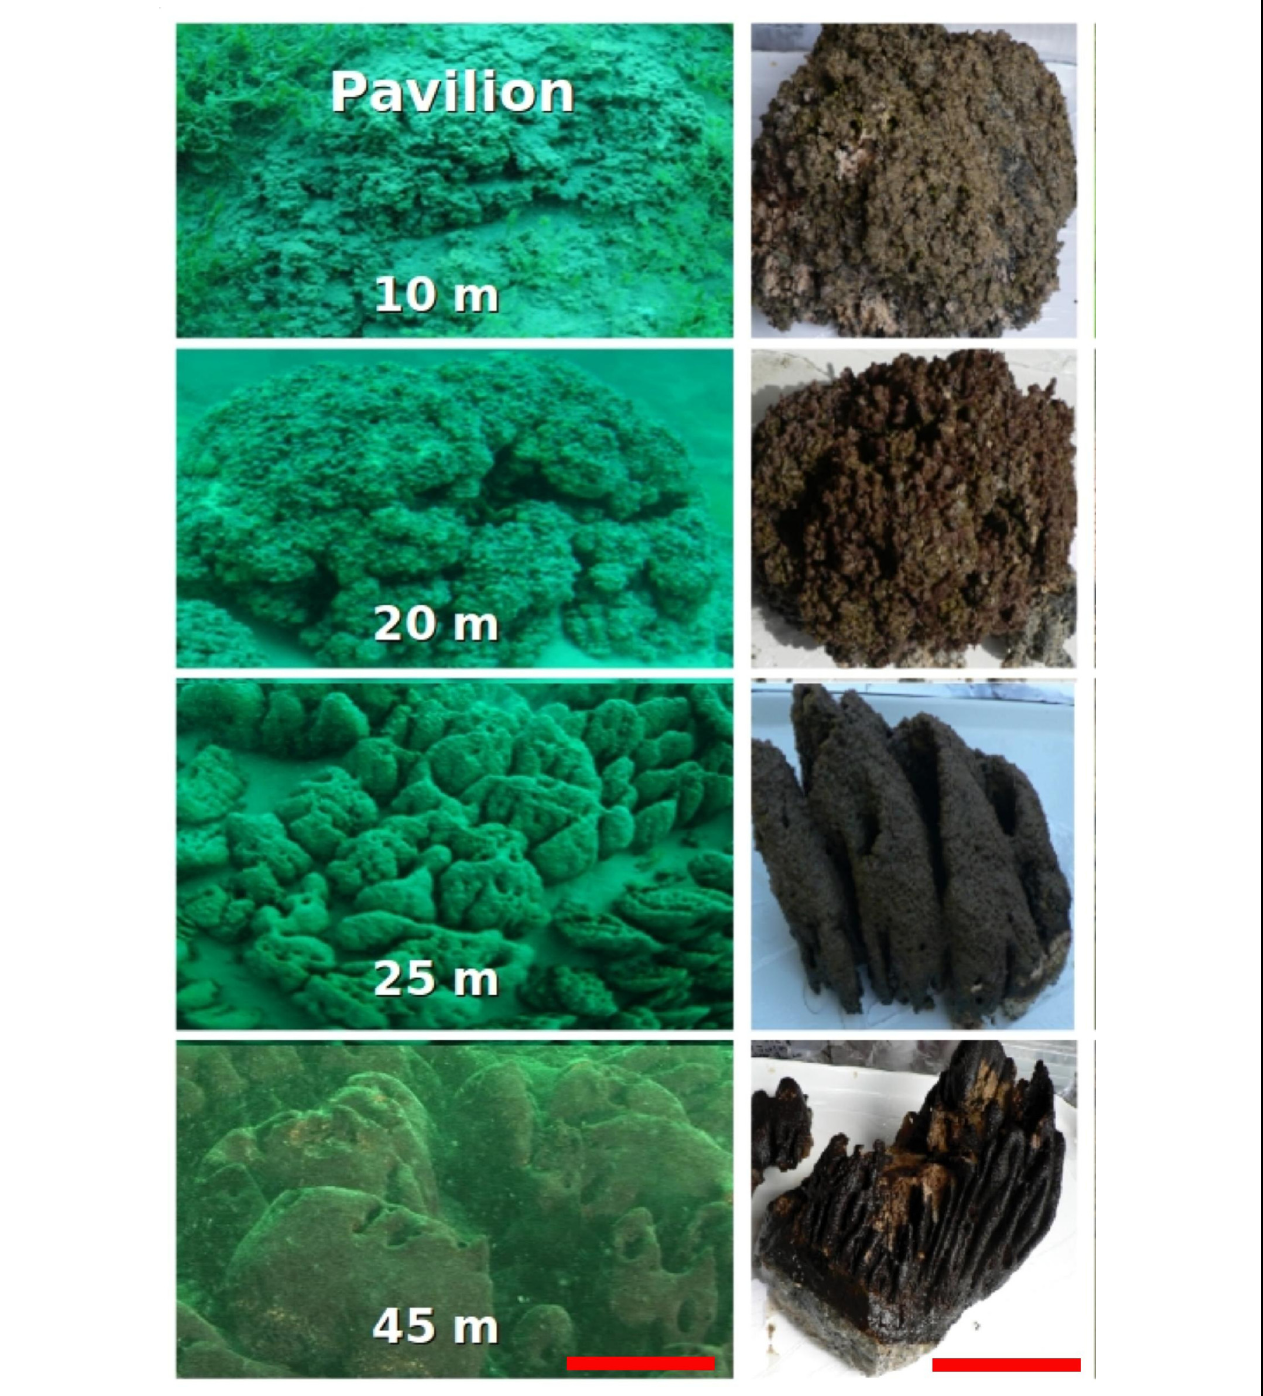
FIGURE 1 | Pavilion Lake microbialite morphology as a function of sampling depth in meters. The scale bar is ∼ 1 m (left) and ∼ 15 cm (right) .